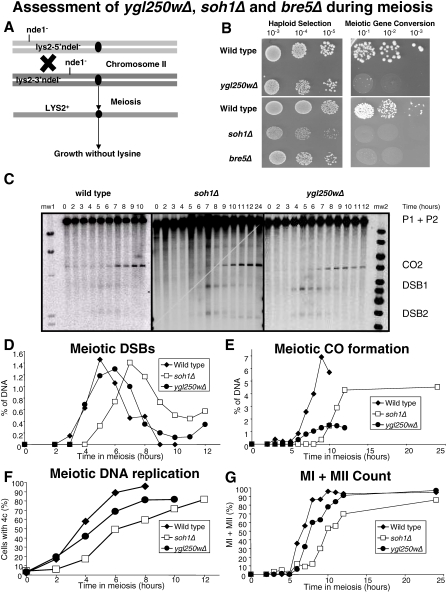
Assessment of YGL250W, SOH1, and BRE5
(A) Schematic representation of Chromosome II from the diploid W303 background which consists of two LYS2 heteroalleles (lys2–5′ndeI− and lys2–3′ndeI−). These were used to measure meiotic gene conversion (see Materials and Methods).(B) Spot test of wild type, ygl250wΔ, soh1Δ, and bre5Δ on haploid selection plates and haploid selection plates without lysine to measure meiotic gene conversion. The reduction in meiotic gene conversion of ygl250wΔ, soh1Δ, and bre5Δ was further assessed by random spore analysis (Table 1).(C) Southern blot of DNA isolated from wild type, soh1Δ, and ygl250wΔ SK1 strains containing the ectopic URA3-ARG4 interval on Chromosome III. The DNA from the indicated times after initiation of sporulation were digested with XhoI then probed to detect COs and DSBs; mw1 represents the λ-HindIII molecular weight marker (Fermentas) and mw2 represents the 1-kb molecular weight marker (Fermentas). The full-sized Southern blots are presented in Figure S1.For graphs (D–G), wild type, ygl250wΔ, and soh1Δ are represented by black diamonds, black circles, and white squares, respectively. The corresponding XhoI-digested Southern blots are presented in Figure 3C.(D) Pre-meiotic DNA replication was assessed for synchronized meiotic cultures by fluorescence-activated cell sorting (FACS) and the change from 2c to 4c DNA content was plotted over time.(E) Nuclear divisions (MI and MII) of the synchronized meiotic cultures in (E) were assessed with fluorescence microscopy using 4′,6-diamidino-2-phenylindole (DAPI) staining to visualize nuclear division.(F) Molecular analysis for DSB (DSB1) signal/total lane signal from Southern blots of DNA extracted from synchronized meiotic cultures.(G) Molecular analysis for CO (CO2) signal/total lane signal from Southern blots of DNA extracted from synchronized meiotic cultures.